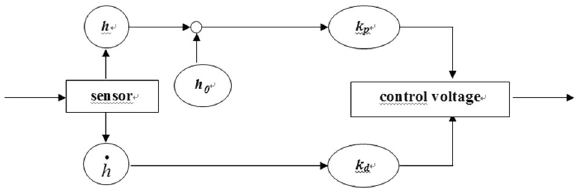
Fig. 4 Suspension controller model